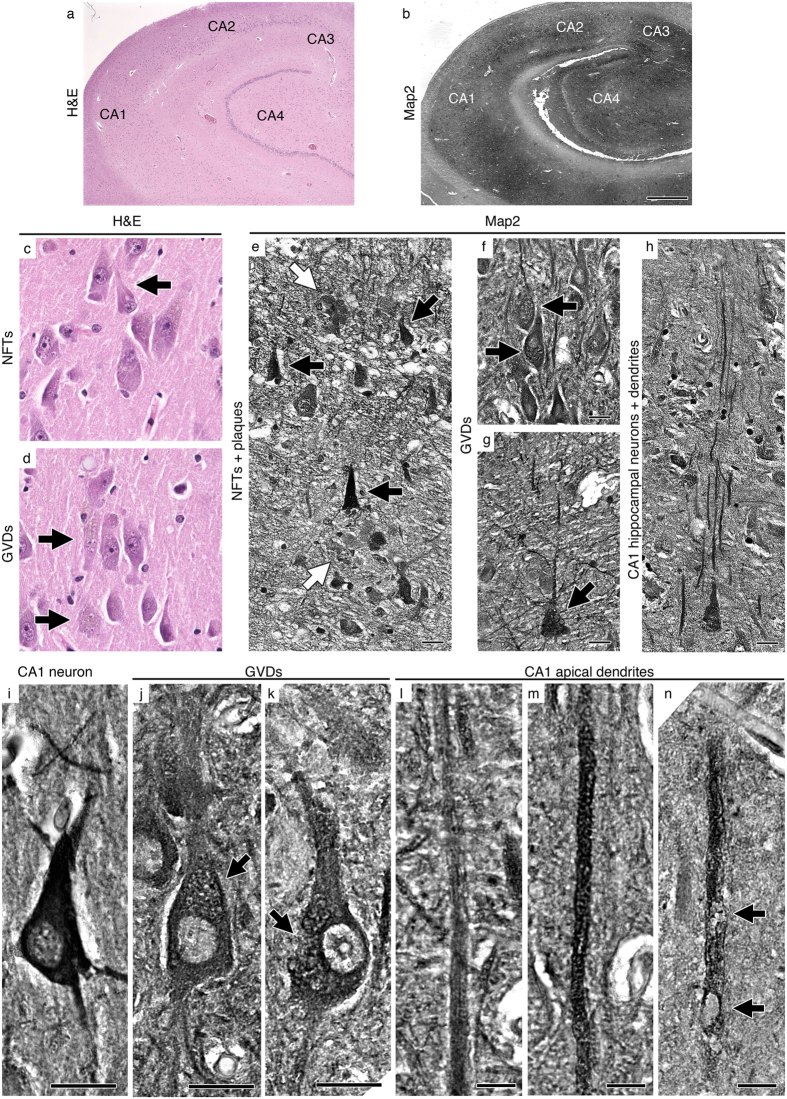
Hippocampal neuron cell bodies, but not dendrites are filled with vacuoles in AD.(a) Representative image of H&E stained AD hippocampus. (b) Representative image of Map2 immunohistochemistry in AD hippocampus. (c,d) Hippocampal neurons as observed in an H&E stained slide. Arrows point to NFTs (c) and GVD (d). (e–h) Hippocampal neurons as observed by Map2 immunohistochemistry. Black arrows point to NFTs (e) and GVD (f,g), white arrows point to plaques. (i–k) Representative images of normal (i) and GVD (j,k) pyramidal neurons in AD CA1. Arrows point to vacuoles. (l–n) Representative images of normal (l,m) and vacuolated (n) apical dendrites in AD CA1. Arrows point to vacuoles. Abbreviations: H&E = hematoxylin and eosin, CA = cornu ammonis, NFT = neurofibrillary tangle, GVD = granulovacuolar degeneration, and AD = Alzheimer’s disease. (b) Scale bar = 1mm, (e–k) scale bar = 20 μm, (l–n). Scale bar = 10 μm.